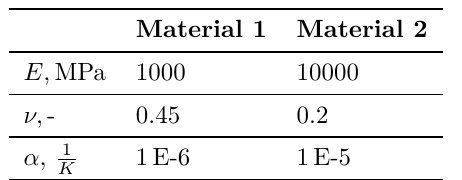
Table 1. Material data for CLTE-simulations